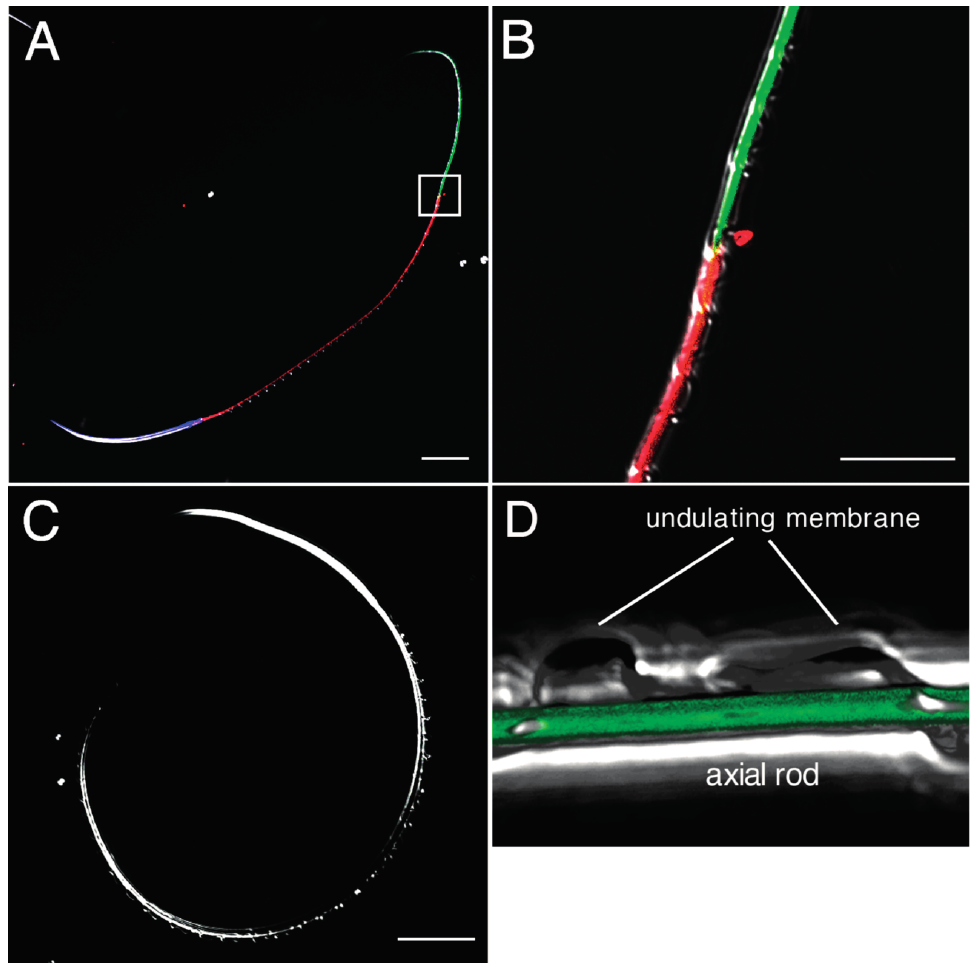
Figure 9. Confocal laser scanning microscopy observations of the Alexafluor 488-labeled AEBSF-bound sperm. ( A ) Sperm was treated with Alexafluor 488-labeled AEBSF, Hoechst 33342 and MitoTracker orange. Green fluorescence from Alexafluor 488 was observed in the principal piece. Blue and red fluorescence derived from Hoechst 33342 and MitoTracker orange, respectively, showing the localizations of the nucleus and mitochondrion; ( B ) High-magnification view of box in ( A ) showing the border between the midpiece and the principal piece. Alexafluor 488-labeled AEBSF bound from the anterior end of the principal piece; ( C ) Sperm not treated with the fluorescence dyes as the control for panel ( A ); and ( D ) 3D-reconstruction of fluorescence images of the principal piece. Alexafluor 488-labeled AEBSF bound to the joint region between axial rod and undulating